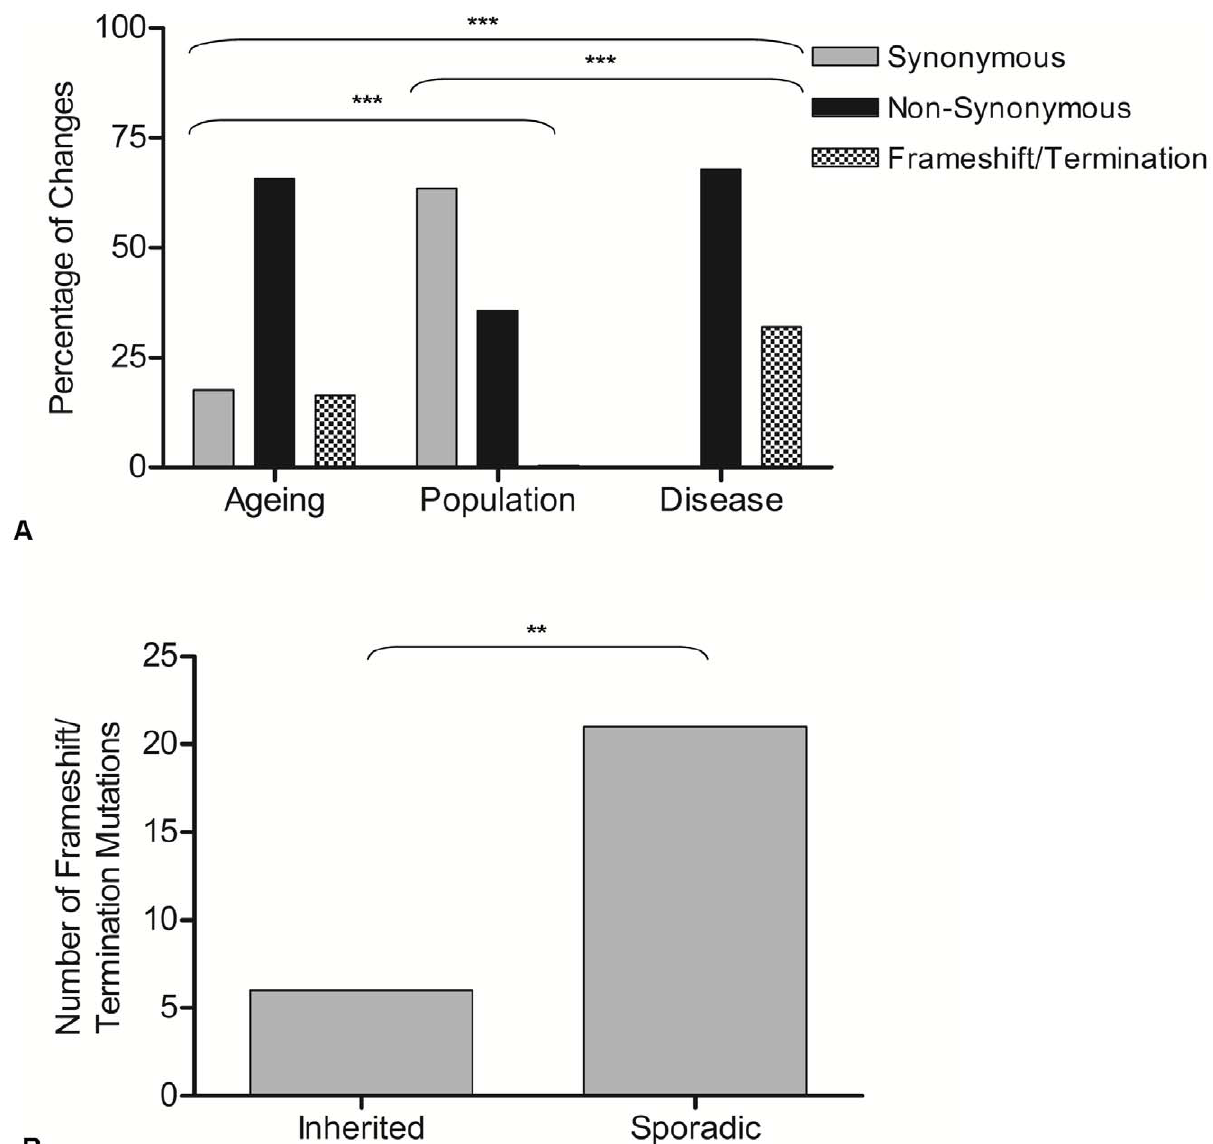
Figure 2. Genetic consequences of mutations observed in ageing, population, and disease. A: The percentage of changes which predict synonymous, non-synonymous and premature termination codons or frameshifts in protein encoding genes. Contingency analysis with Bonferroni correction for multiple testing was carried out on the frequencies of the changes in each gene type (ageing n=81, population n=155, disease n=76). Thresholds for statistical significance are; *** , 0.0003, ** 0.003, *=0.017. B: Frequency of termination codon and frameshift mutations in inherited and sporadic disease-causing mtDNA mutations. Chi-squared analysis showed a significantly higher frequency such mutations in sporadic than inherited cases (p=0.003).